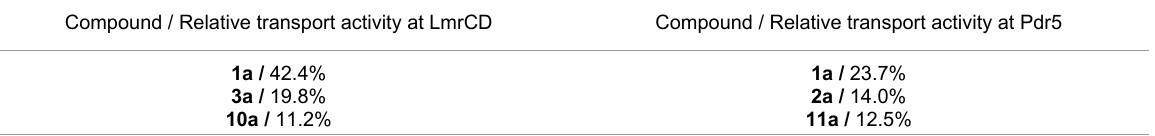
Table 1: Relative transport activity of LmrCD and Pdr5 in the presence of zosuquidar ( 1a ) and selected new 5-oxyquinoline derivatives ( 2a – 13a ). a